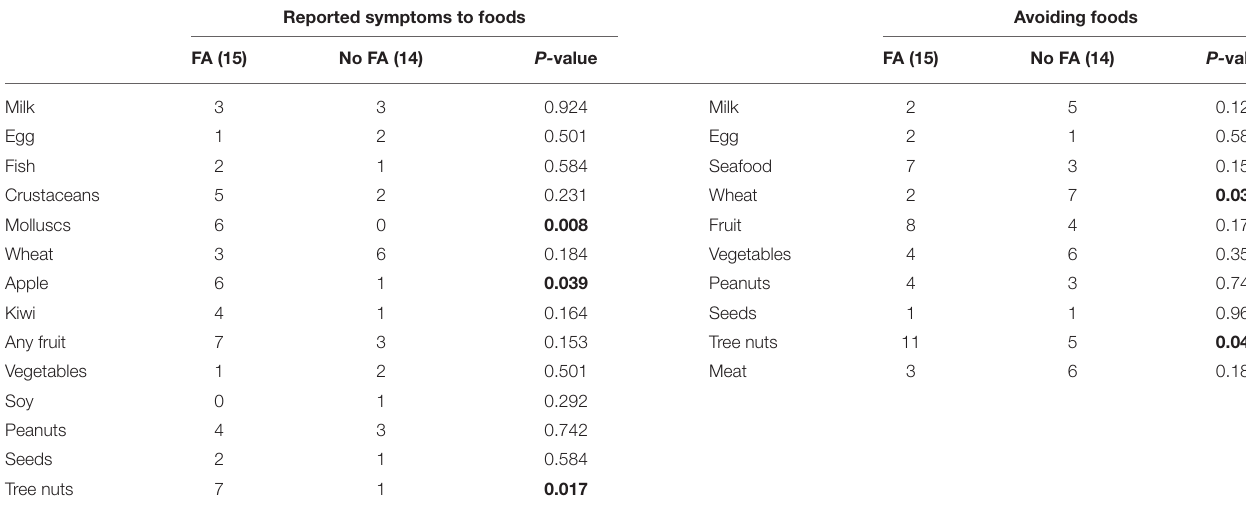
TABLE 2 | Foods reported to provoke reactions or being